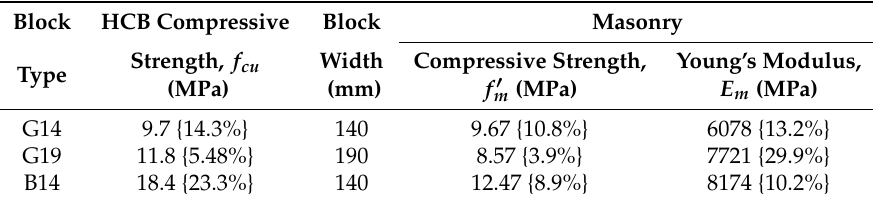
Table 3. Results of stack-bond prism compression